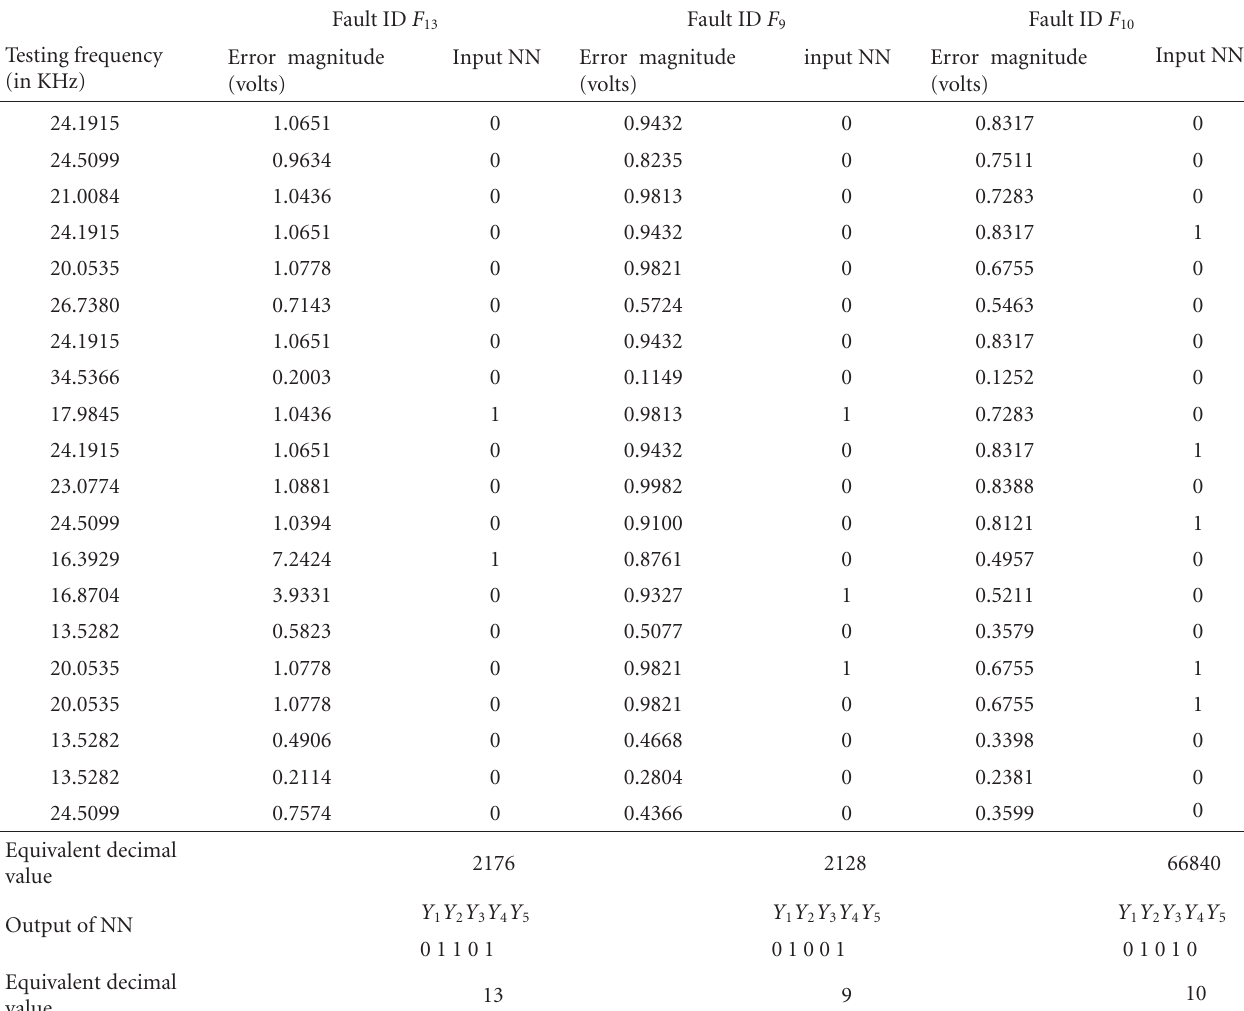
Table 5: ANN inputs and outputs for test cases F 13 , F 9 , and F 10 .